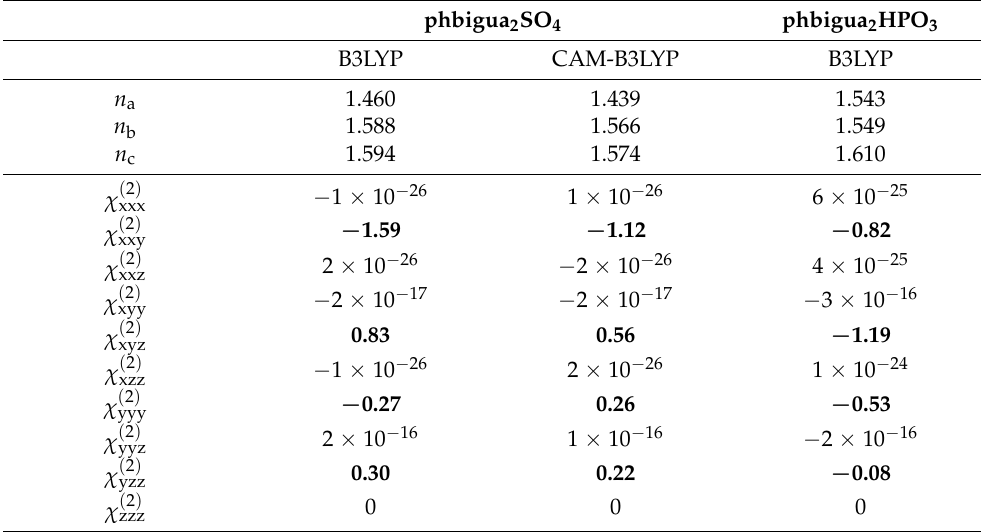
Table 3. Calculated refractive indices and independent χ (2) tensor components (A.U.) of phbigua 2 SO 4 and phbigua 2 HPO 3 crystals ( λ = ∞